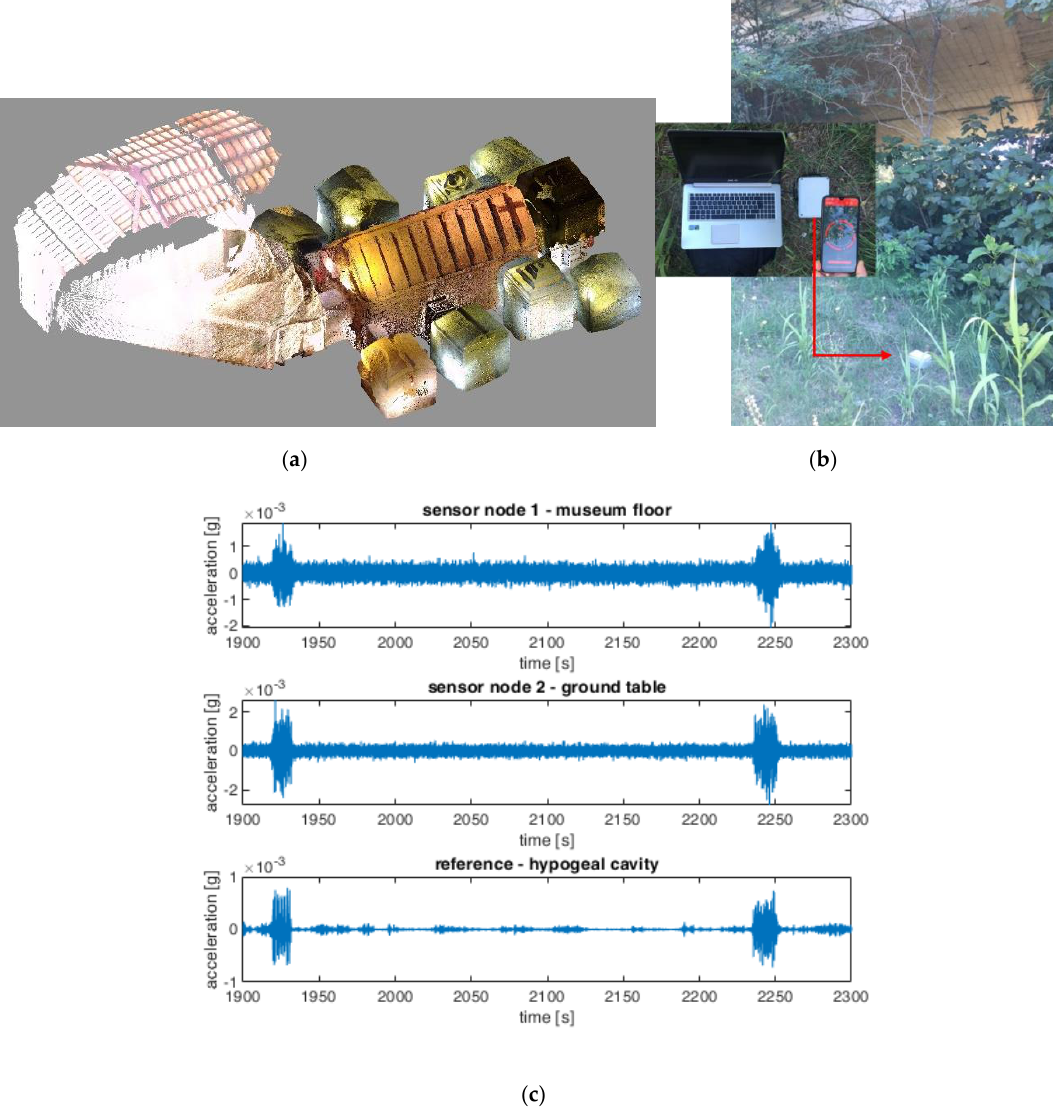
Figure 7. Measurement campaign at different positions in the “Volumni Hypogeum” archeological site. ( a ) Laser scan of the underground cavity, showing the structure of the cavity, stairs, and museum building [28]; ( b ) location of sensor node 2, at the ground table above the cavity; ( c ) data acquired by sensor node 1 on the museum floor, sensor node 2 at the ground table outside the museum above the cavity, and reference accelerometer, placed inside the cavity.